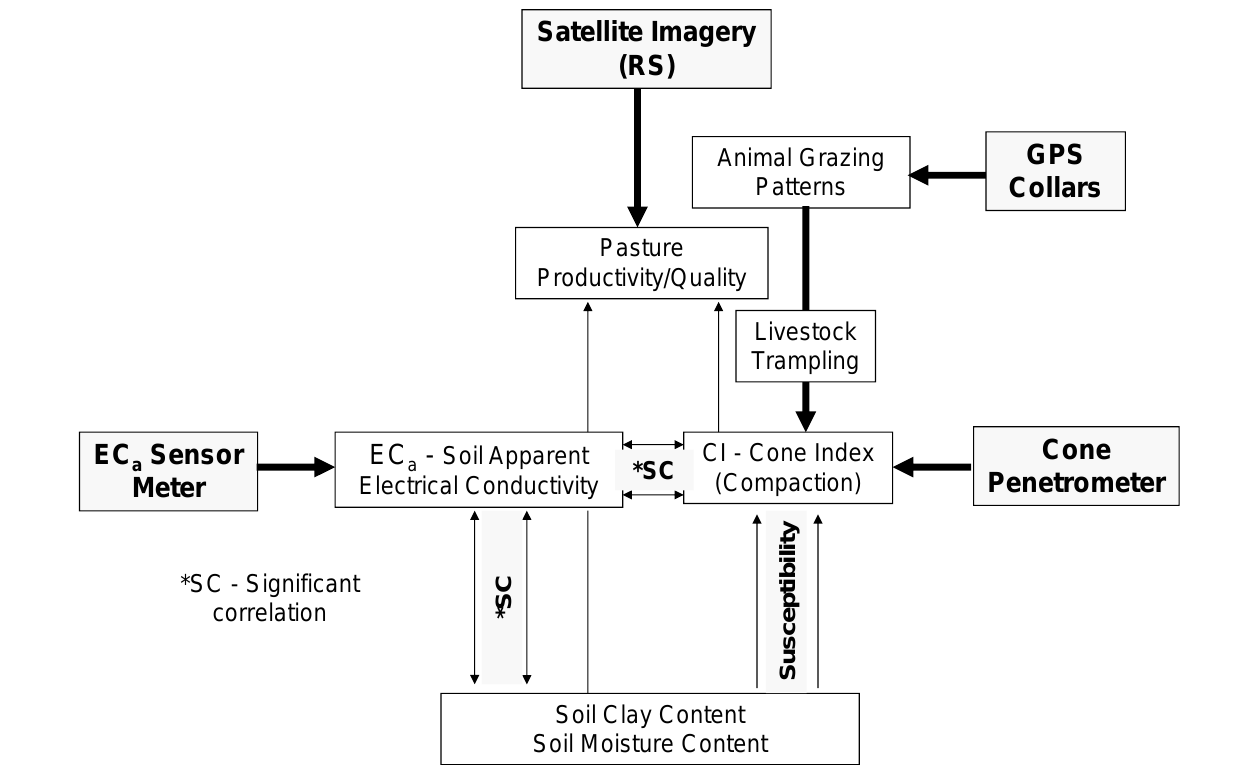
Figure 18. Global technological approach used in this study.